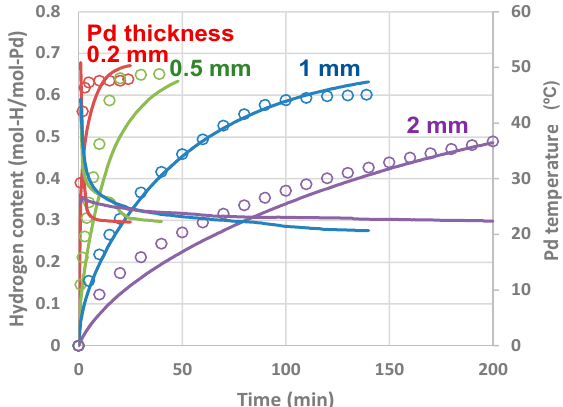
Figure 13. Experimental results (blank circles) and calculation fittings (solid lines) of time evolution of hydrogen content in Pd plates of various thicknesses. The single set of parameters k sb0 = 1.4 × 10 13 s − 1 and k bs0 = 6.2 × 10 12 s − 1 was used for all the calculations.